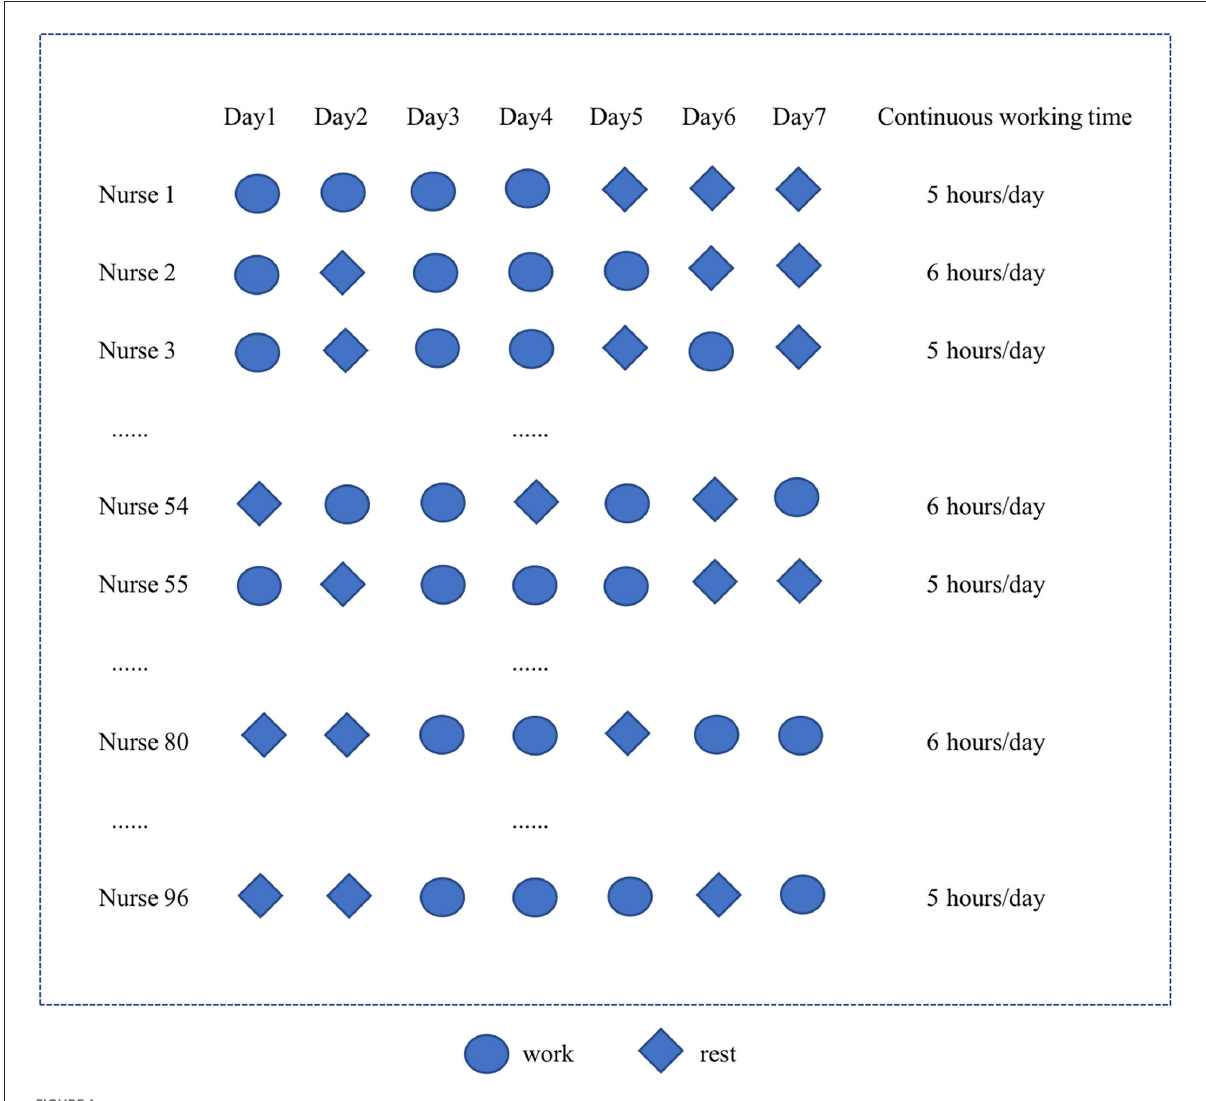
FIGURE1 Illustration of the working schedule for the participating nurses in negative pressure isolation ward